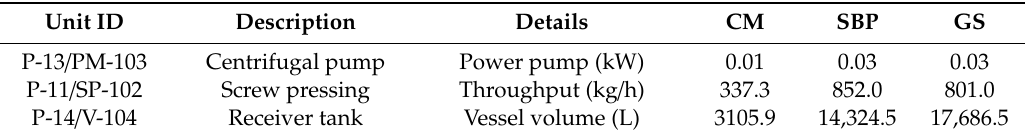
Table 7. Main parameters used for simulation of the digestate processing obtained after the anaerobic digestion of the feedstocks CM, SBP, and GS.